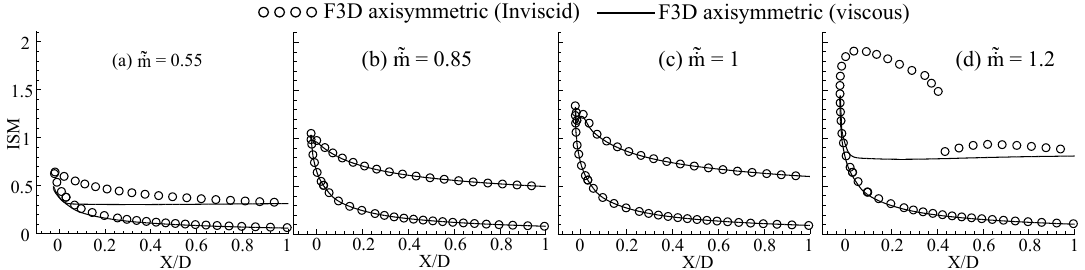
Figure 8. Axial variation of ISM for F3D axisymmetric viscous and inviscid